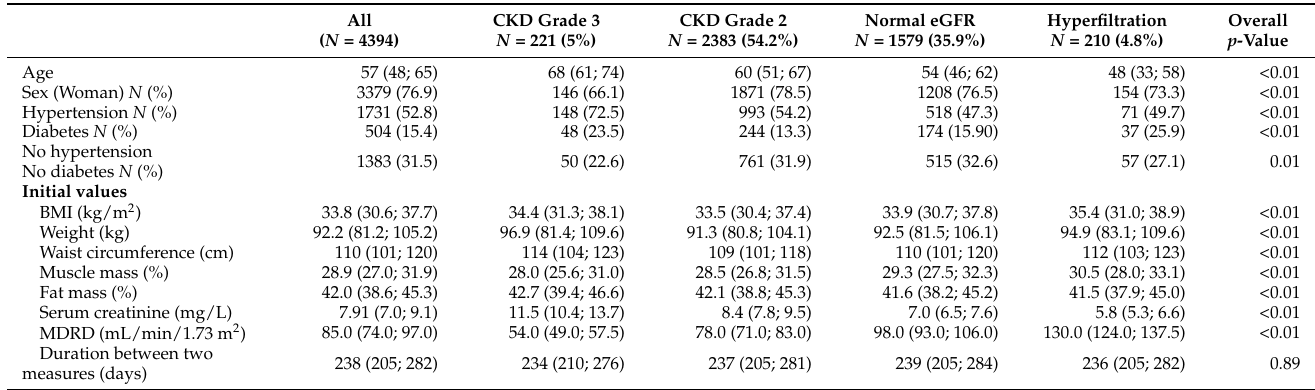
Table 1. Characteristics of the patients classified according to their MDRD